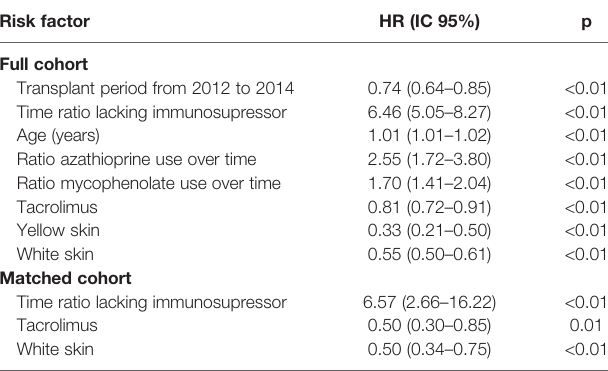
TABLE 4 | Multivariate analysis – Risk factors associated with graft